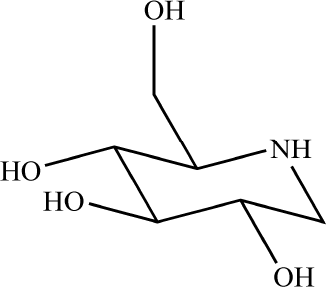
Figure 1. The chemical structure of 1-deoxynojirimycin.